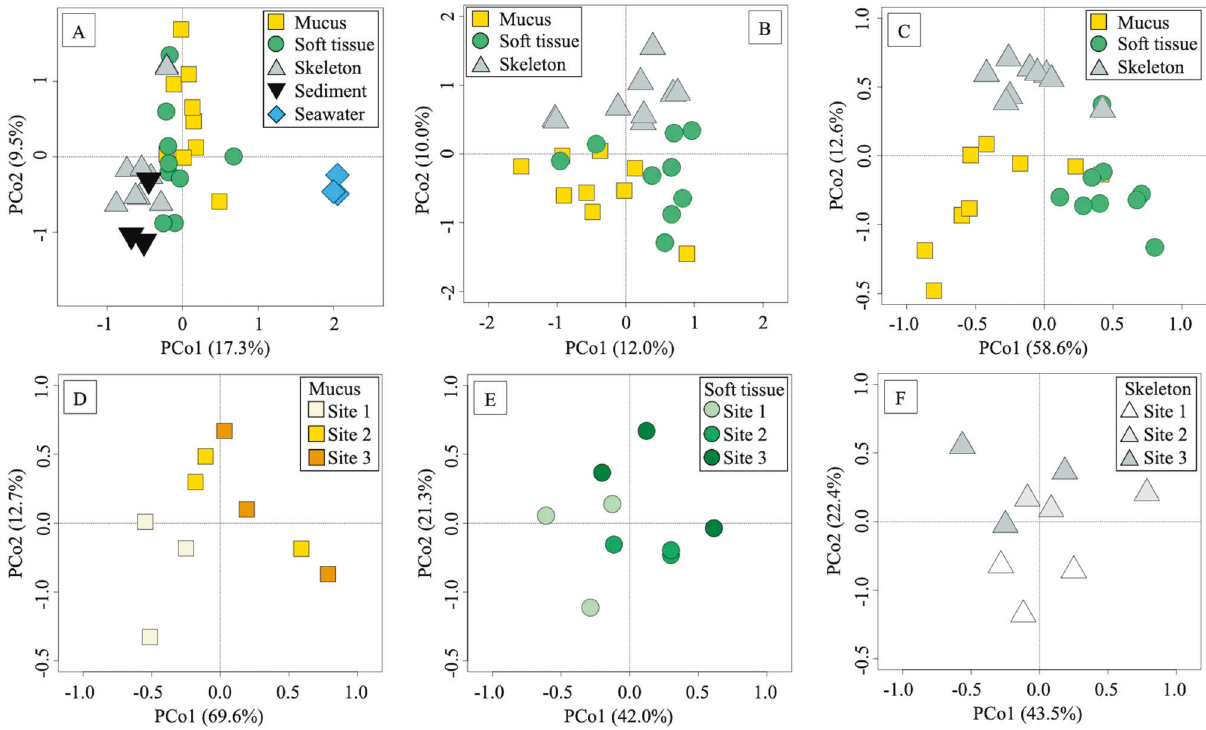
Fig. 1 Overall microbiome compositional structure of B. europaea and the surrounding environment. Principal Coordinate Analyses (PCoAs) of the Bray-Curtis distances calculated on microbiome pro fi les at genus taxonomic level, obtained from 16S rRNA gene sequencing ( A and B ) and phylogenetic assignation of metagenomic reads ( C – F ), describing different features of the available coral and environmental samples. The fi rst and second principal components (PCo1 and PCo2) are plotted in all graphs and the percentage of variance in the dataset explained by each axis is reported. A PCoA based on 16S rRNA gene data showing the structure of B. europaea associated microbiomes compared to the surrounding environment (permutation test with pseudo-F ratio, p value = 0.001). B PCoA based on 16S rRNA gene data showing B. europaea microbiomes associated to the 3 different coral compartments (permutation test with pseudo-F ratio, p value = 0.001). C PCoA based on metagenomics data showing B. europaea microbiomes associated to the 3 different coral compartments (permutation test with pseudo-F ratio, p value = 0.001). D – F PCoAs based on metagenomics data comparing B. europaea microbiome in different anatomic compartments in samples collected at different acidi fi ed conditions. A – C legend: mucus samples, yellow squares; soft tissue samples, green circles; skeleton samples, gray triangles; water samples, light blue diamonds; sediment samples, black reversed triangles. PCoA based on metagenomics data comparing B. europaea mucus ( D ), soft tissue ( E ) and skeleton ( F ) microbiomes in corals collected at different acidi fi ed conditions. Samples are depicted as symbols (same as in panels A – C ) fi lled in shades of color from lighter color (Site 1, control site, non- acidi fi ed) to darker colors (Site 2, moderate acidi fi cation, and Site 3, strong acidi fi